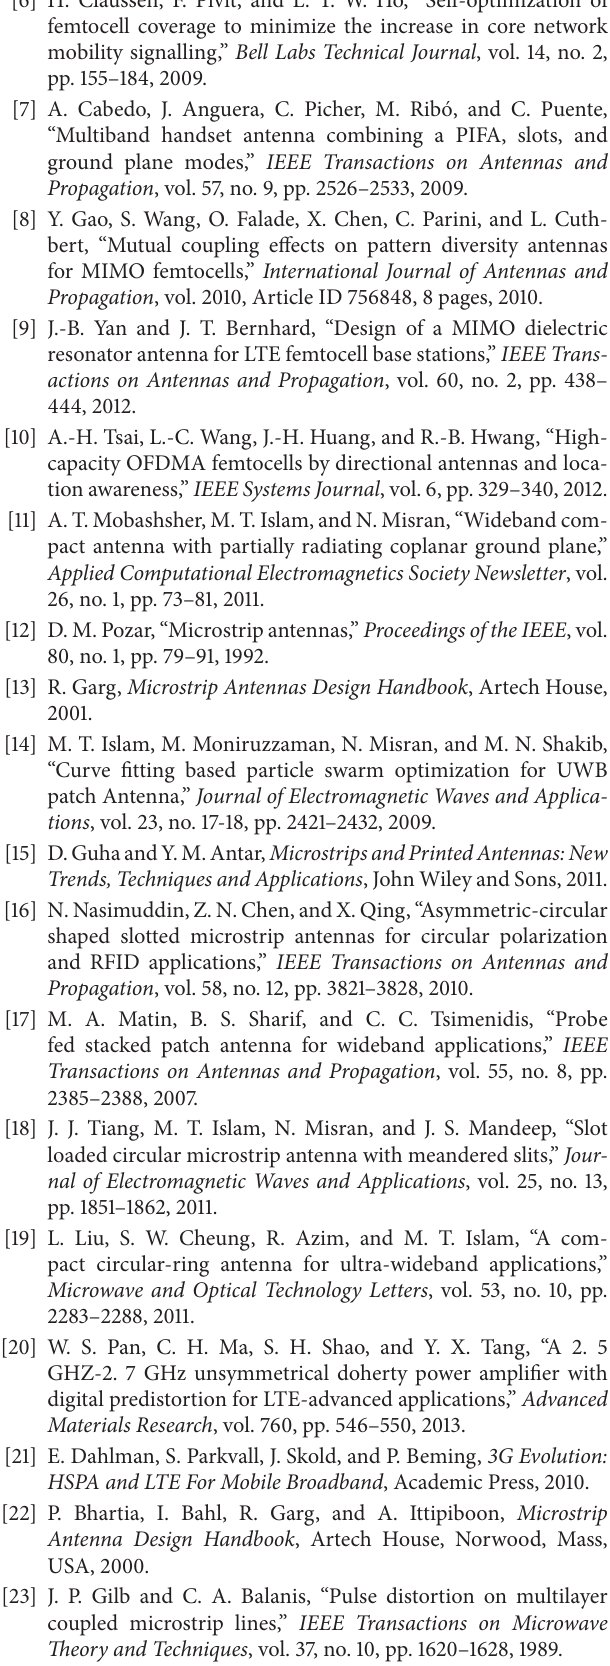
Figure 8: S - parameters for different combination of antennas. 11